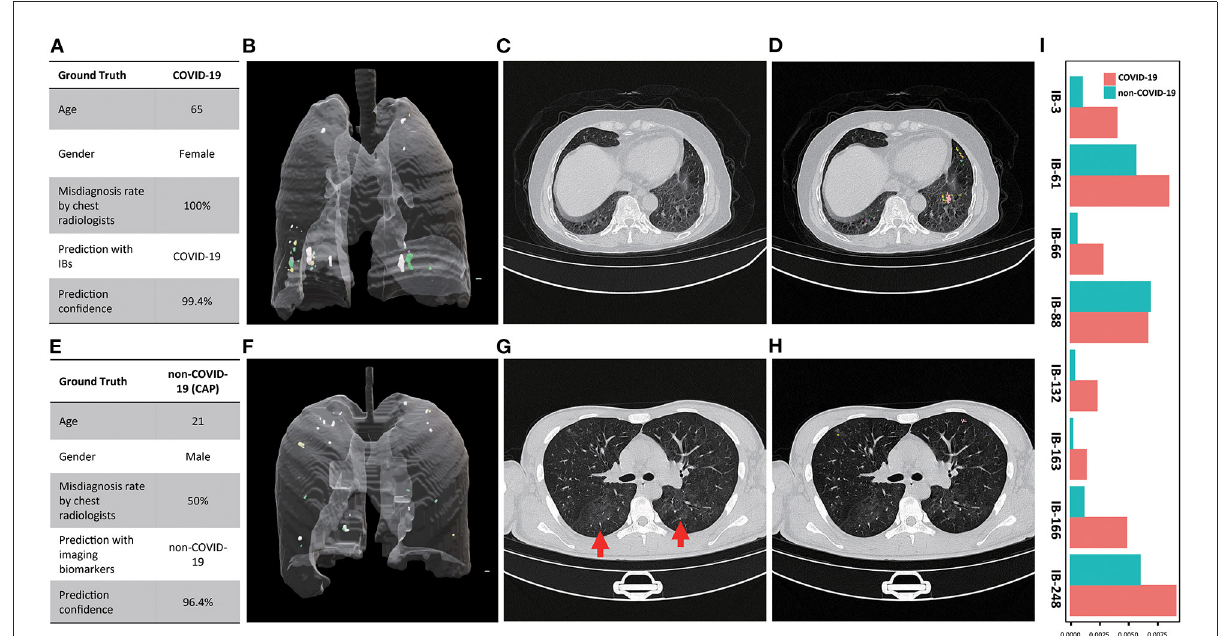
FIGURE6 Examples of misdiagnosed cases by participating chest radiologist(s). (A) Characteristics of the COVID-19 patient and the corresponding diagnosis (chest radiologists)and screening (imaging biomarkers) results; (B) 3D multi-spectral staining of the COVID-19 patient (3D animation can be found in Supplementary Video 10); (C) Representative CT image slice of the COVID-19 shows no typical abnormity related to COVID-19, which led to the false negative decision of both chest radiologist; (D) the corresponding 2D multi-spectral staining of the selected CT image slice (2D animation of the entire CT scan can be found in Supplementary Video 12); (E) Characteristics of the CAP patient and the corresponding diagnosis and screening results; (F) 3D multi-spectral staining of the CAP patient (3D animation can be found in Supplementary Video 11); (G) Representative CT image slice of the CAP patient shows the typical while subtle image characteristics (GGO, marked by red arrows) of the COVID-19 in the upper lobe of both lungs, which led to the false positive decision by one of the chest radiologists; (H) The corresponding 2D multi-spectral staining of the selected CT image slice (2D animation of the entire CT scan can be found in Supplementary Video 13); (I) Relative abundance of imaging biomarkers differentiate the COVID-19 from CAP